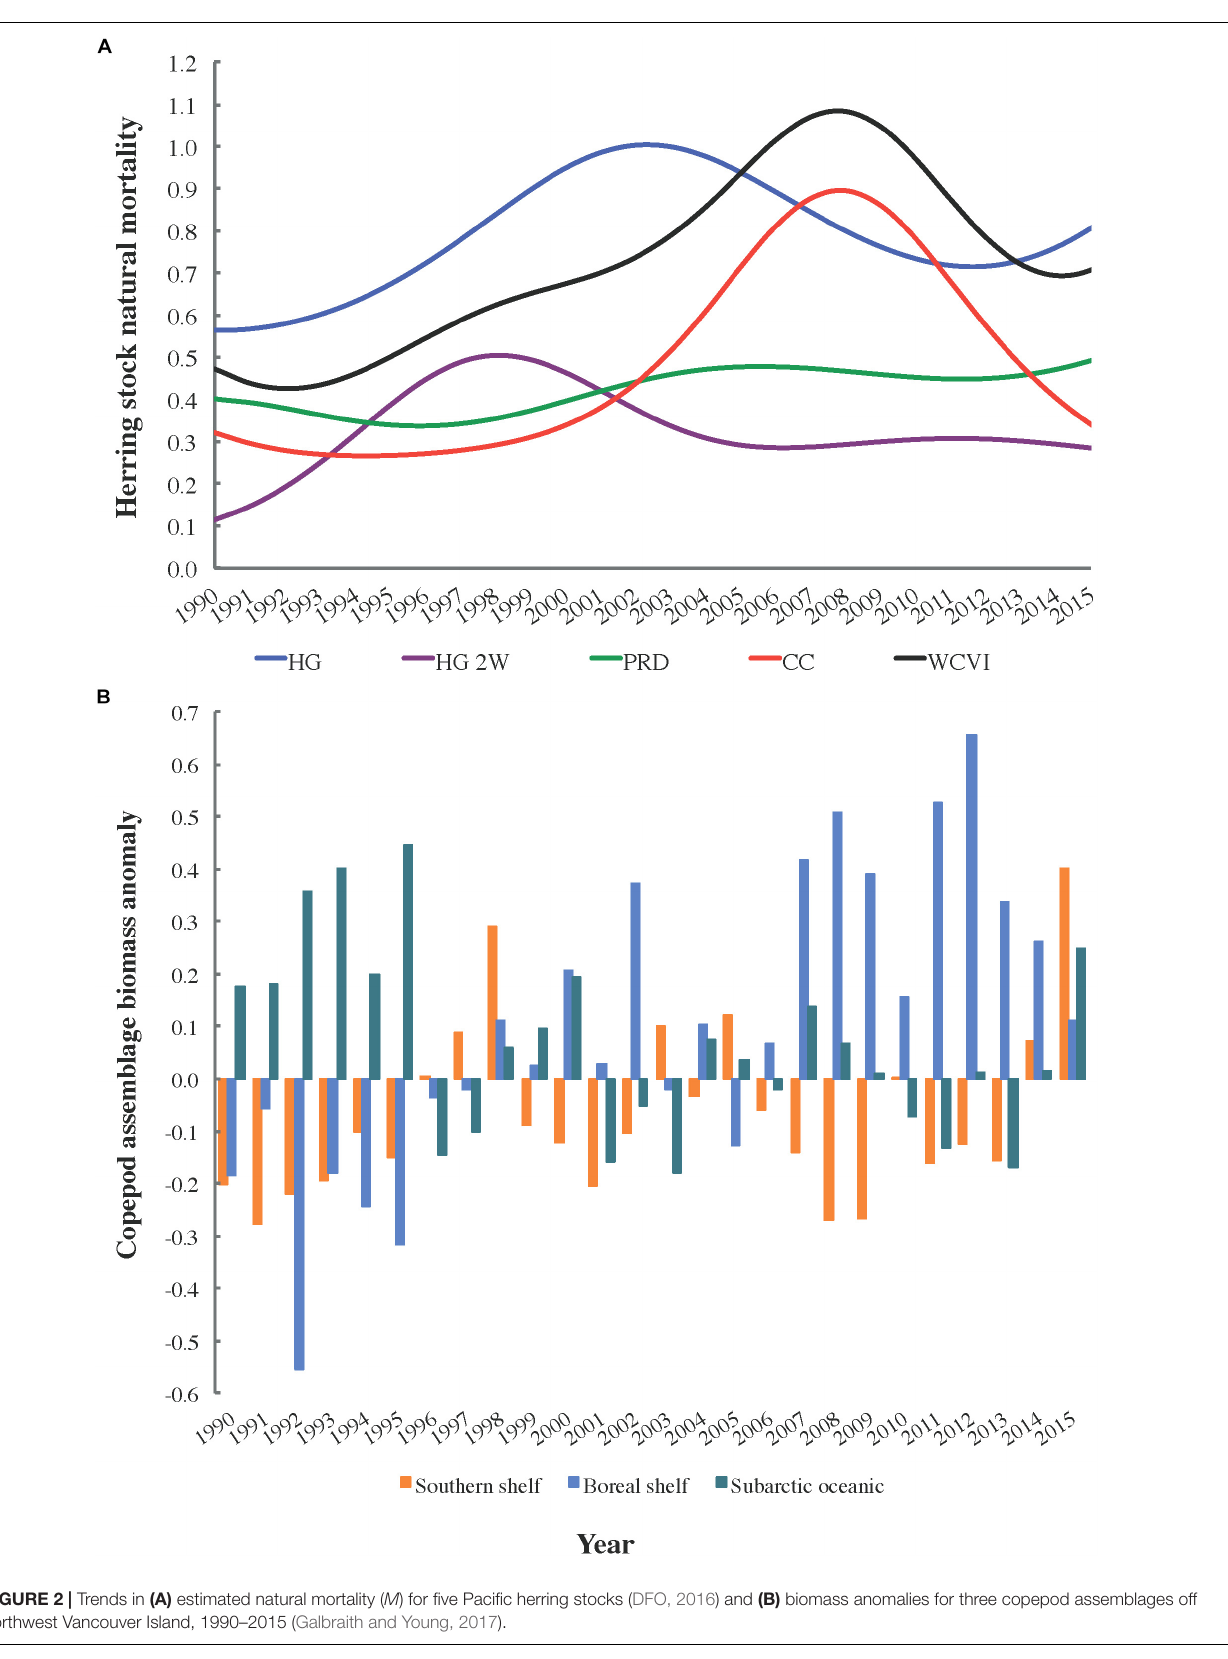
Frontiers in Marine Science |